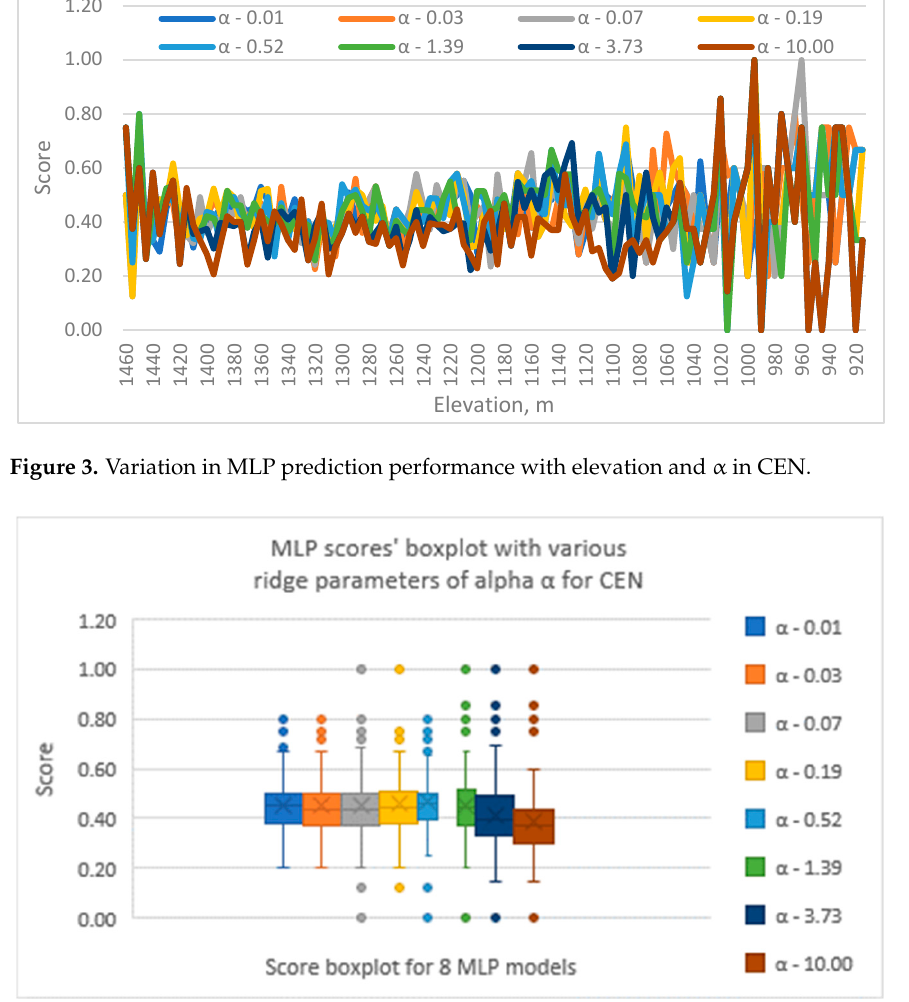
Figure 4. Box plots of results in various α on MLP performance in CEN.